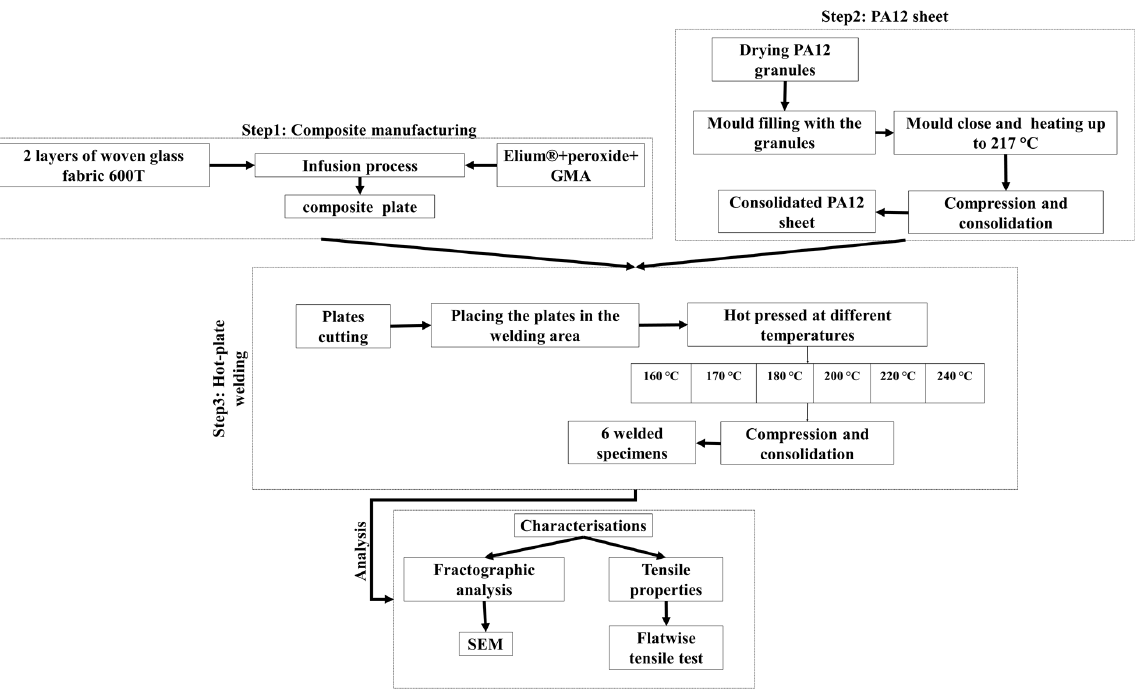
Figure 1. The experiment steps for hot-plate welding of reactively compatibilized acrylic-based composites/polyamide (PA)-12